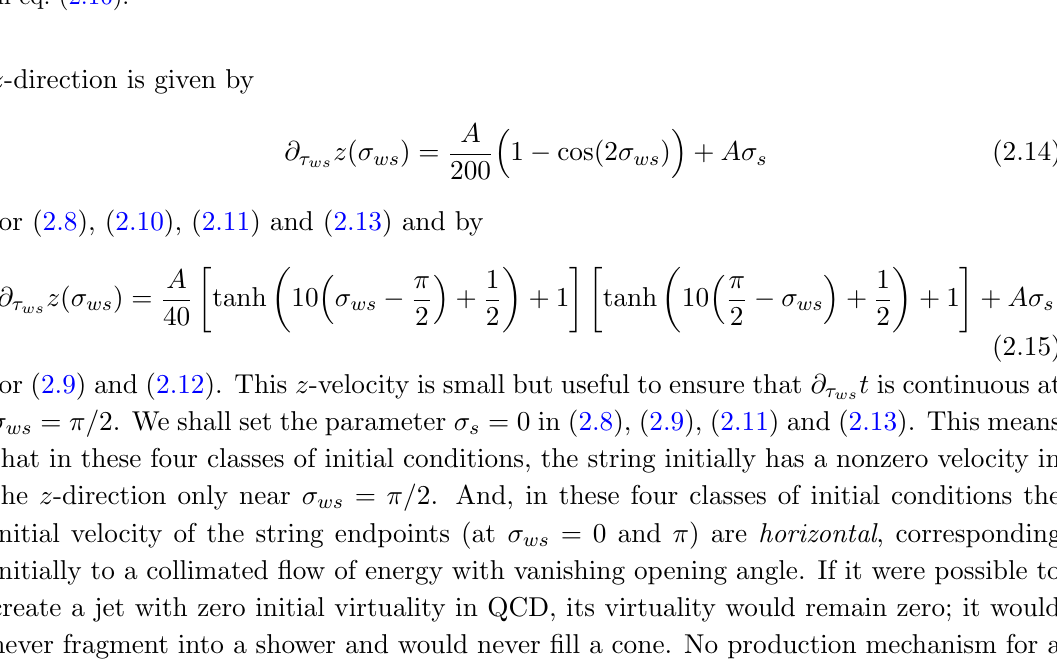
Figure 2 . We show the shapes of the pro(cid:12)les that we use for the initial conditions on the velocities in AdS of the strings that we analyze, as given in eqs. (2.8){(2.13) and eqs. (2.14){(2.15). The solid curves show the initial velocity of the string in the x -direction as a function of the worldsheet coordinate (cid:27) ws . (The string endpoints are at (cid:27) ws = 0 and (cid:25) ; the string midpoints are at (cid:27) ws = (cid:25)= 2.) The dashed curves give the initial velocity in the z -direction (\downward" into the bulk of AdS), enhanced by a factor of 10 for visibility. As discussed in the text, the small but nonzero z velocity is useful numerically to make @ (cid:28) t continuous at the midpoint of the string. The relationship ws between the worldsheet time coordinate (cid:28) ws and the AdS time t is given in terms of these functions in eq.